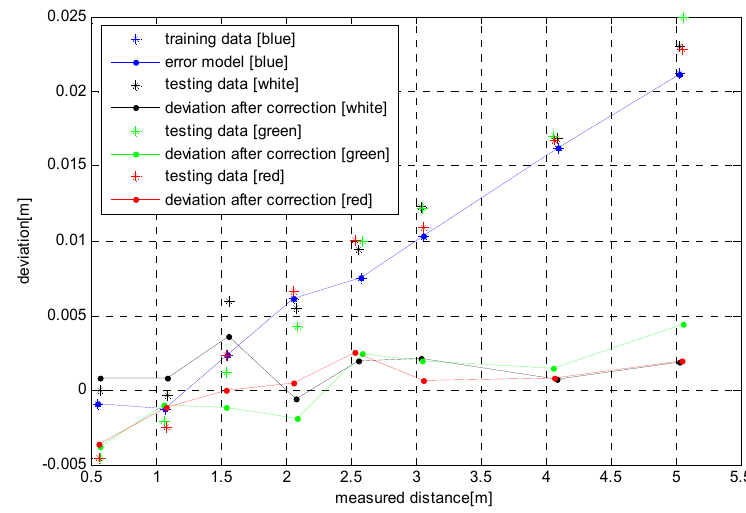
Figure 15. Depth error correction results of various colors and error model.